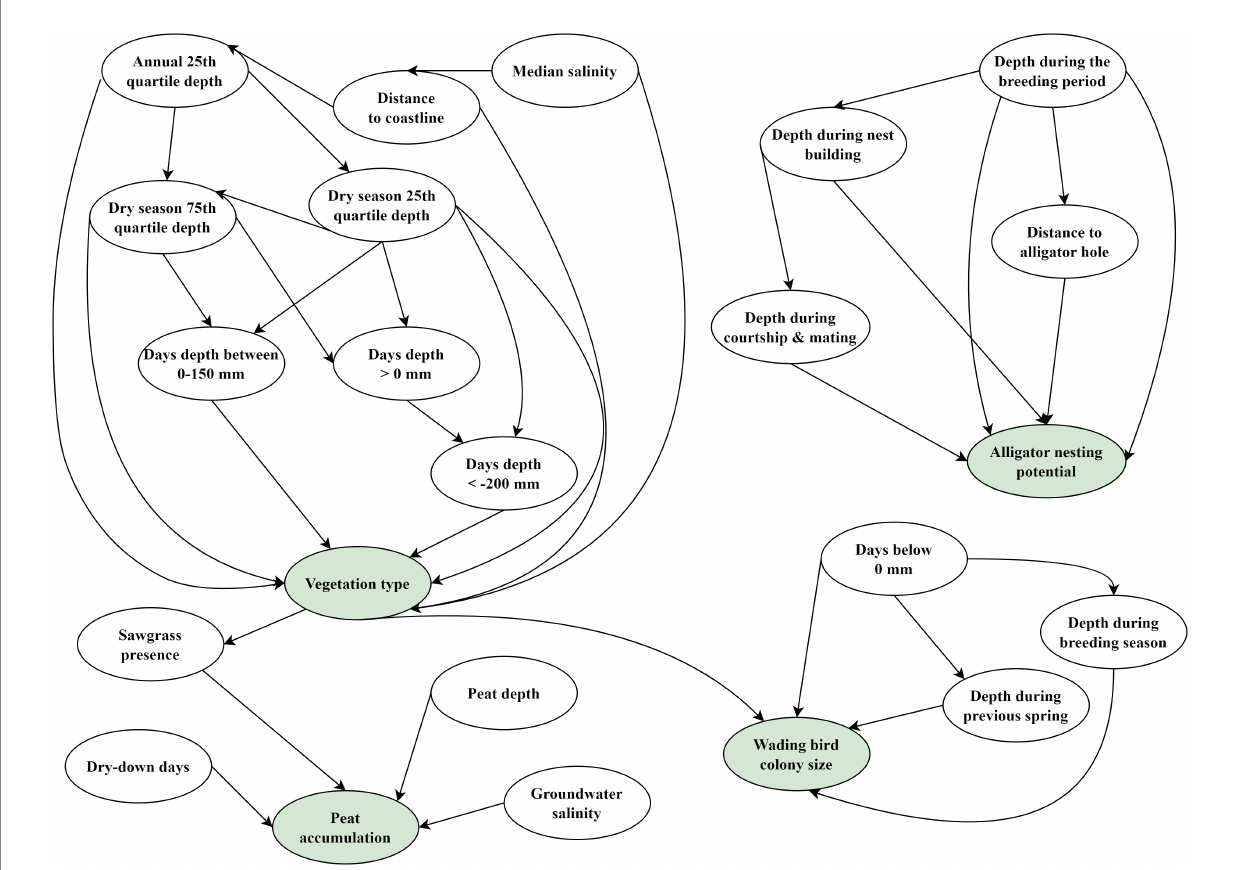
FIGURE 3 Structure of the Bayesian network modules currently used in the Everglades Vulnerability Analysis (EVA). Green shaded nodes are output nodes, while white non-shaded nodes are variable input nodes. For descriptions of each node and the discretization levels used, see Supplementary Table S1 in Supplementary